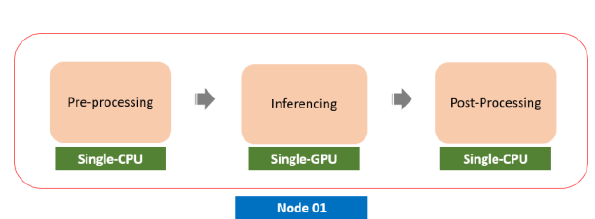
Figure 6. A semantic diagram of single-CPU single-GPU MAPLE workflow model using a single HPC node.